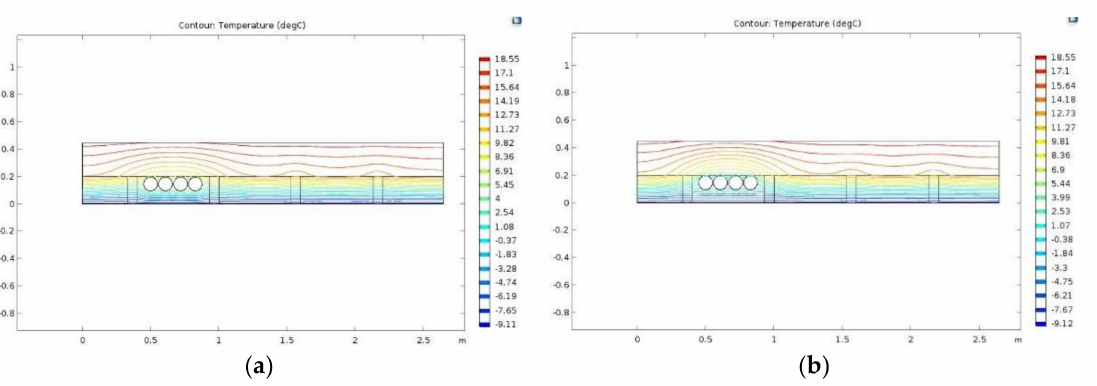
Figure 8. Isotherm distribution in COMSOL Multiphysics. ( a ) circulation air temperature +5 ◦ C. ( b ) circulation air temperature +0 ◦